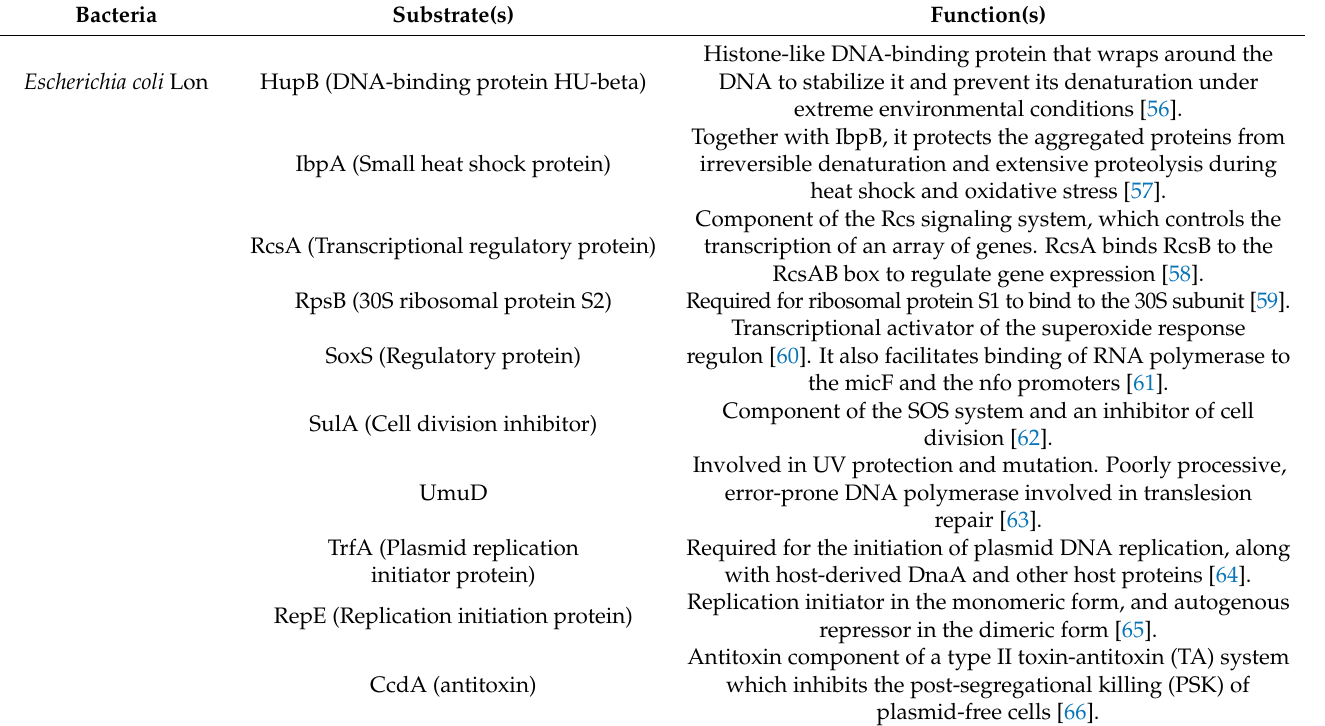
Table 1. Important substrates of bacterial Lon